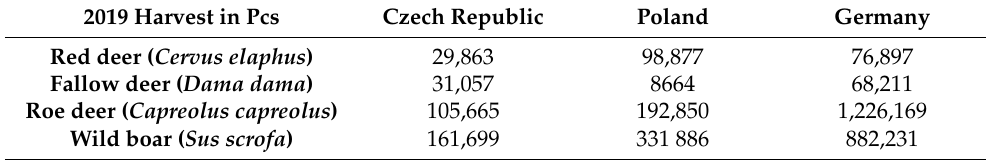
Table 2. Selected ungulates in Czech Republic hunting statistics (in pieces) Table 3. Selected ungulates harvested per 1000 capita (comparison-adjusted per 1000